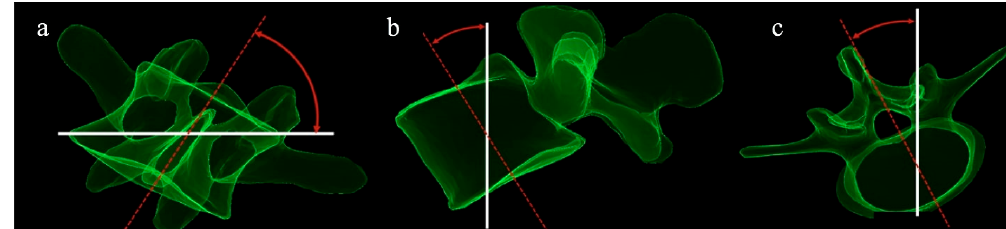
Figure 2. Vertebral rotations. ( a ) Coronal tilt; ( b ) sagittal tilt; ( c ) axial rotation. Sagittal spinopelvic parameters: